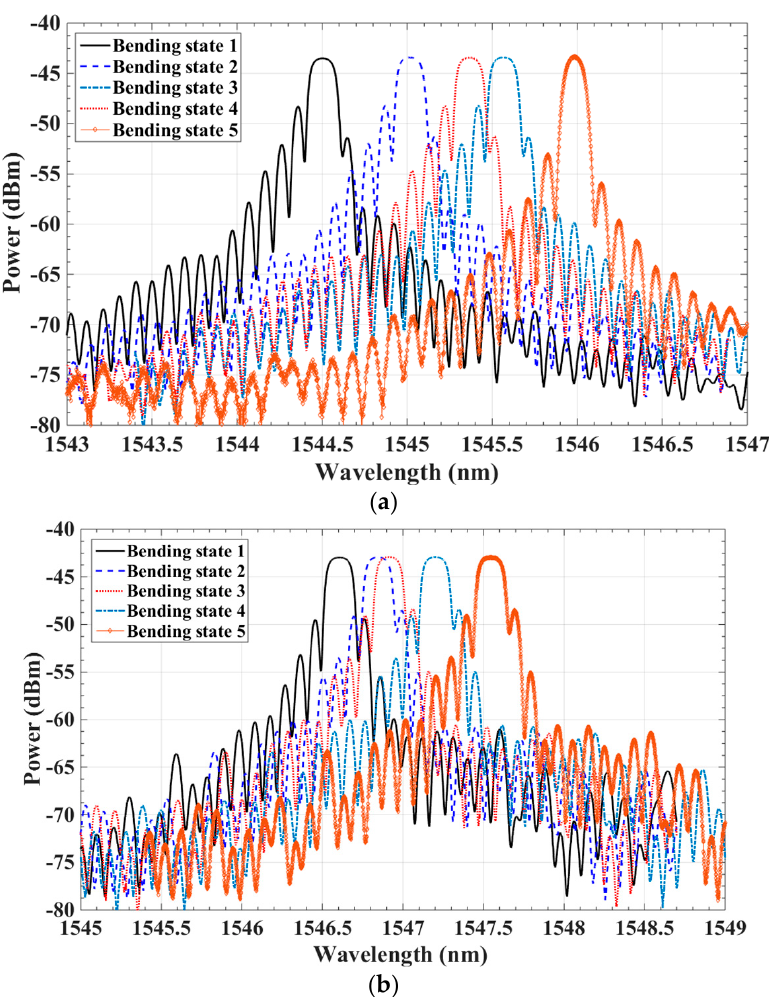
Figure 11. The wavelength shift of two FBG sensors at different bending states. ( a ) FBG 1. ( b ) FBG 2. When the curvature of the FBGs increases from 0 m − 1 to 25 m − 1 , the relationship of the wavelength shift and the curvatures of the soft actuator are illustrated in Figure 12. All measurements have respective average values which were taken from six independent experiments.